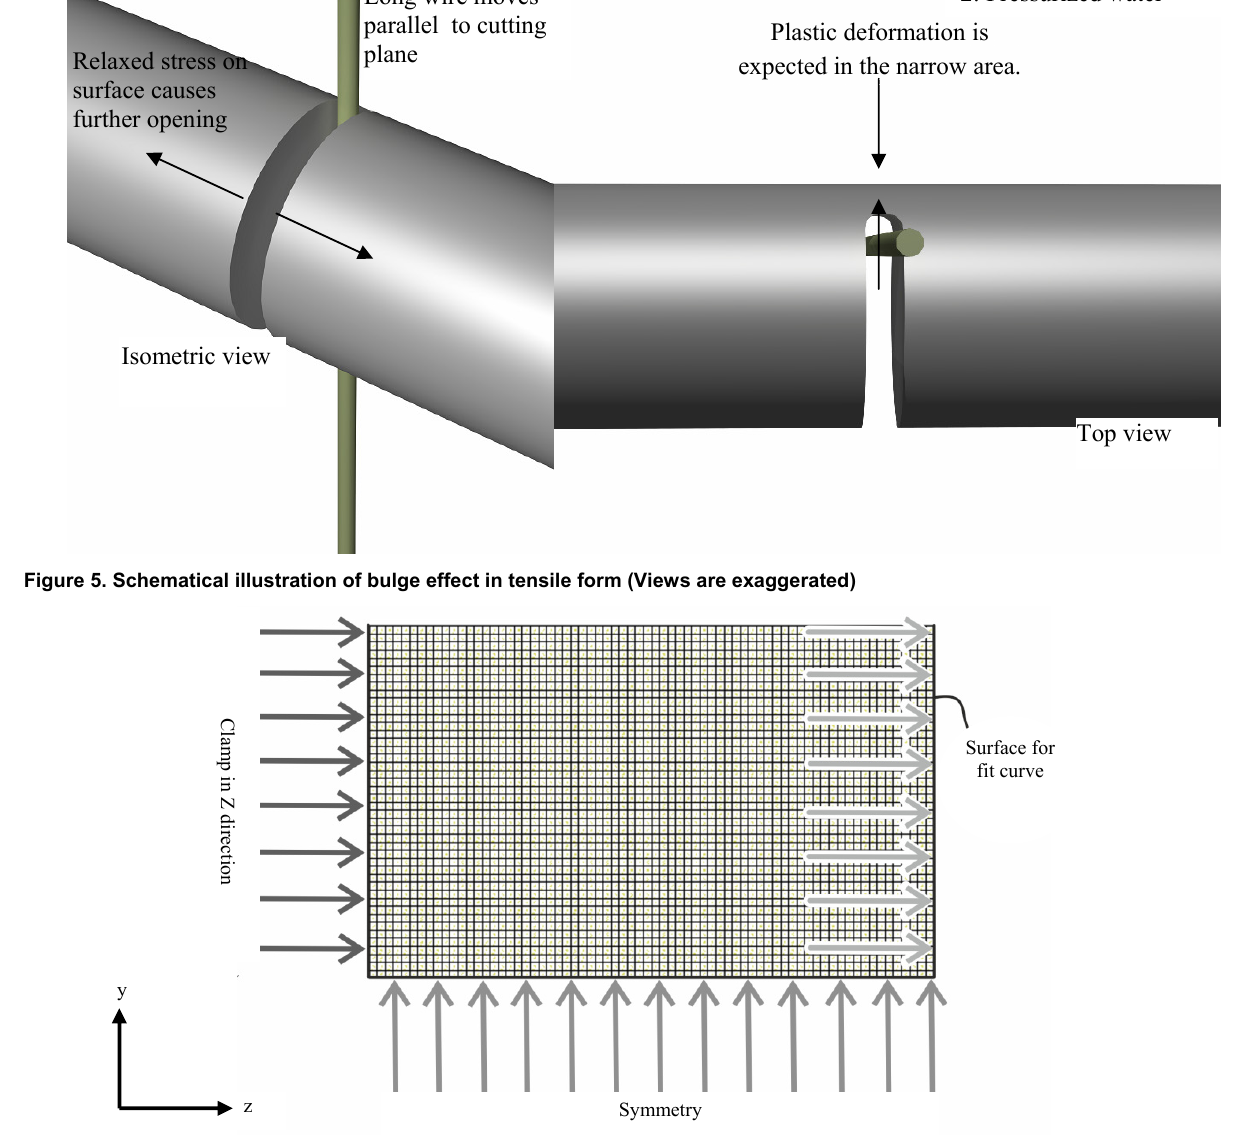
Figure 6. Boundary conditions for linear elastic FEA for the contour method using MSC